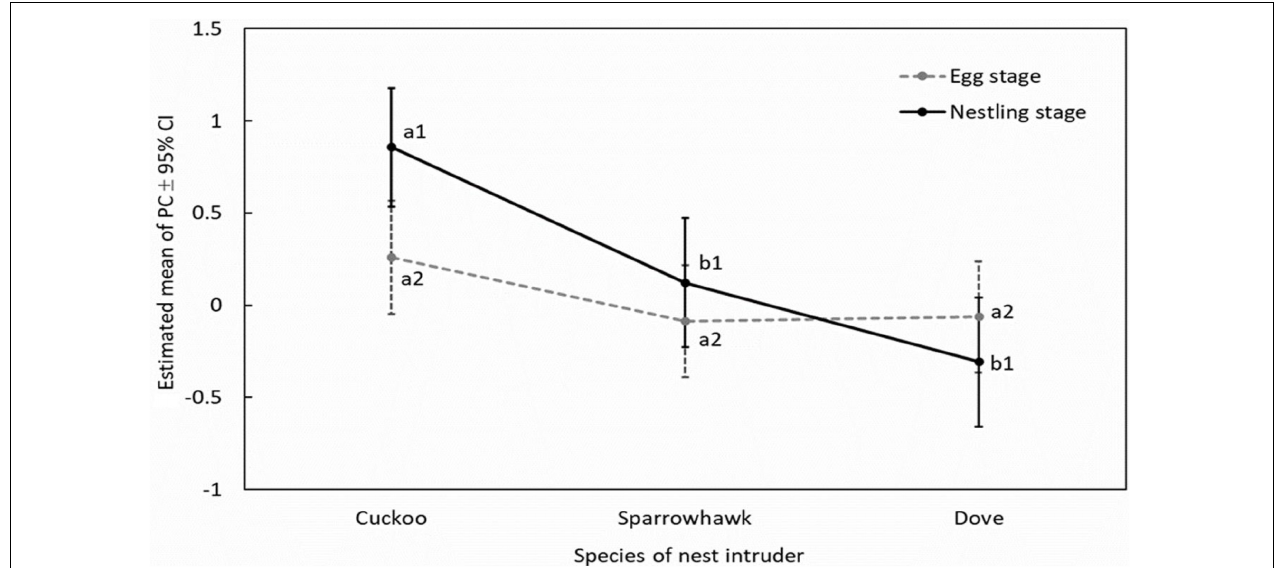
FIGURE 2 | Pairwise comparisons for behavioral responses between nest intruders by least significant difference in A. orientalis . Significant differences are indicated by different letters; a1 and b1 refer to nestling stage, and a2 refers to egg stage.